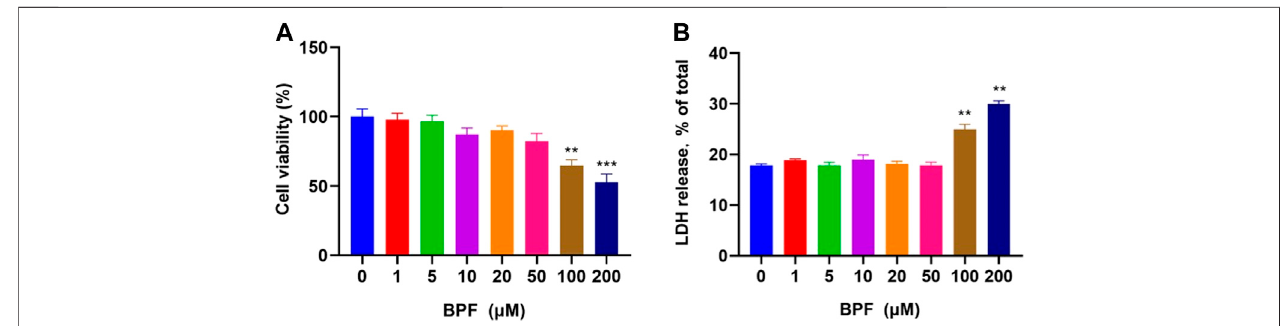
FIGURE 1 | Cytotoxicity induced by BPF on RAW264.7 macrophages: (A) CCK-8 assay. (B) LDH release assay ( n = 5). After calculation, the 50% inhibitory concentration (IC 50 ) of BPF was 248.60 μ M. Data are expressed as means ± SEM. ** p < 0.01 and *** p < 0.001 are compared with the control group (0 μ